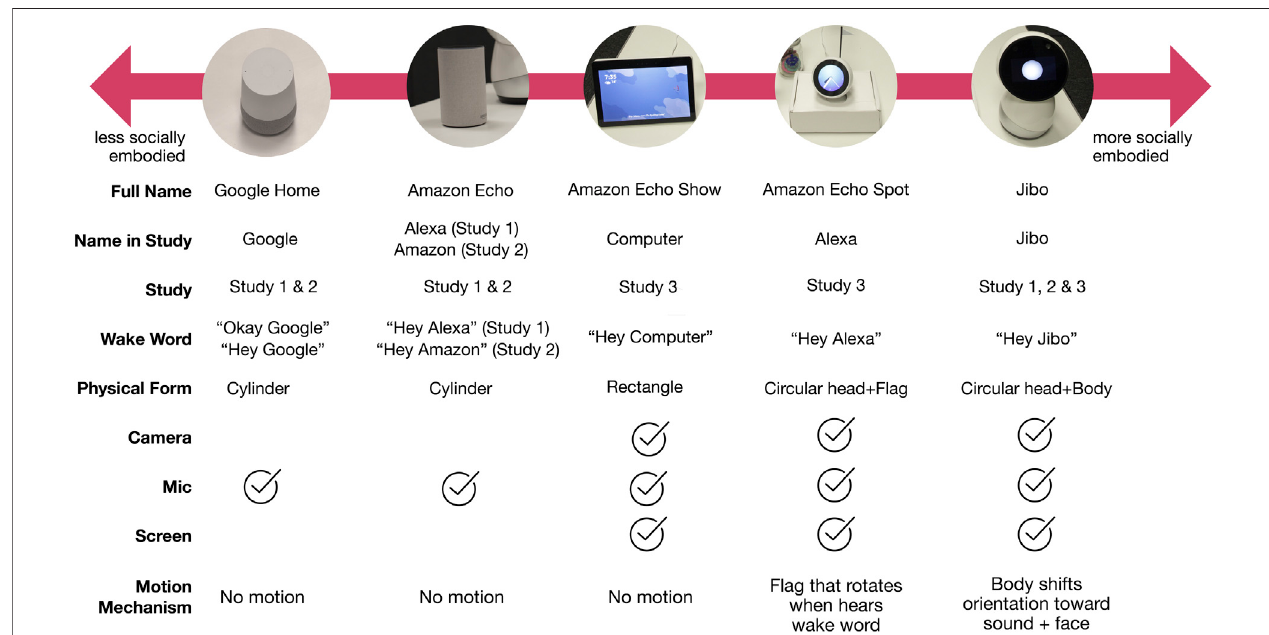
FIGURE 1 | Spectrum of VUIs that represents fi ve commercially available VUIs mapped on to varying levels of embodiment going from less socially embodied to more socially embodied.